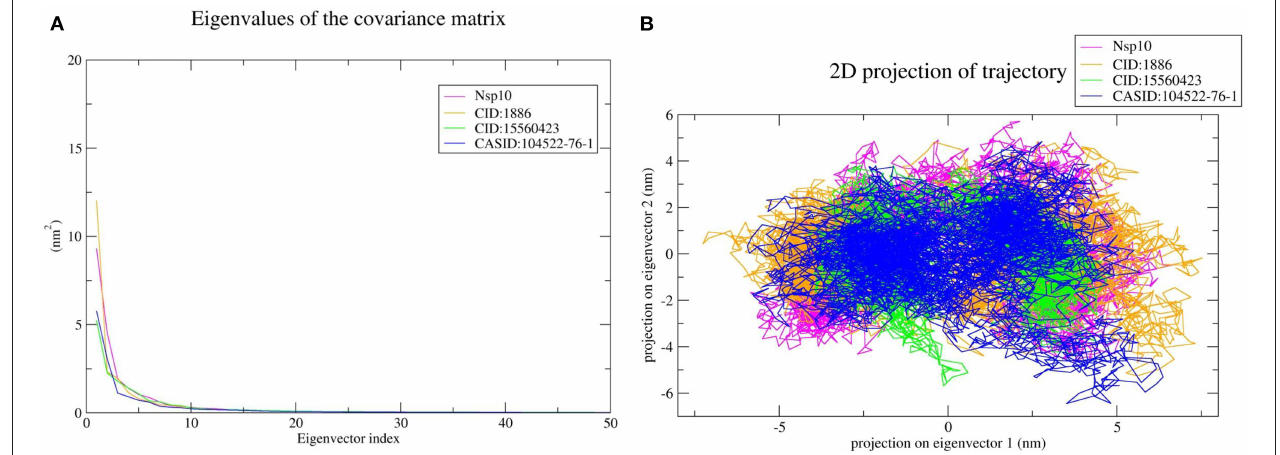
FIGURE 8 | Principal component analysis of Nsp10 and Nsp10-phytochemical complexes. (A) Plots of eigenvalues vs. the first 50 eigenvectors derived from the final 50 ns of MD simulations. (B) The first two eigenvectors representing the motion of Nsp10 and its complexes in phase space. Magenta, orange, green, and blue colors